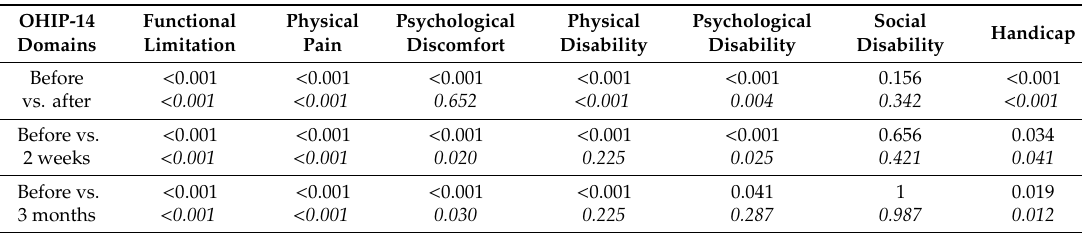
Table 6. The probability values ( p -values) describing the di ff erences regarding the mean OHIP-14 score between di ff erent stages of orthodontic treatment in each domain, independently for the cancer survivors’ and control groups.